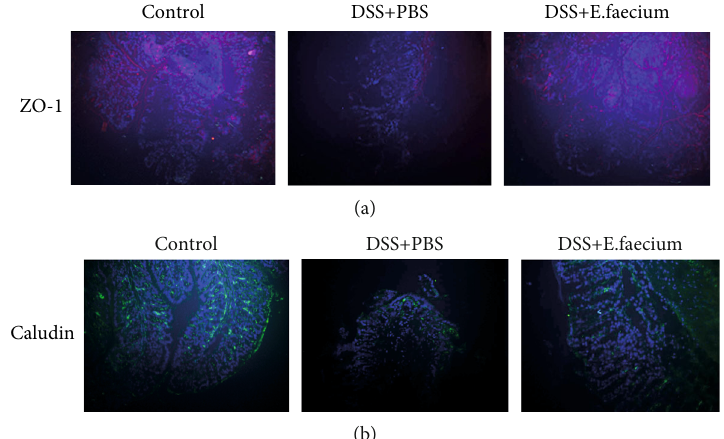
Figure 3: E. faecium protects against intestinal injury by strengthening tight junctions. Immunohistochemical staining of (a) ZO-1 and (b) claudin in the